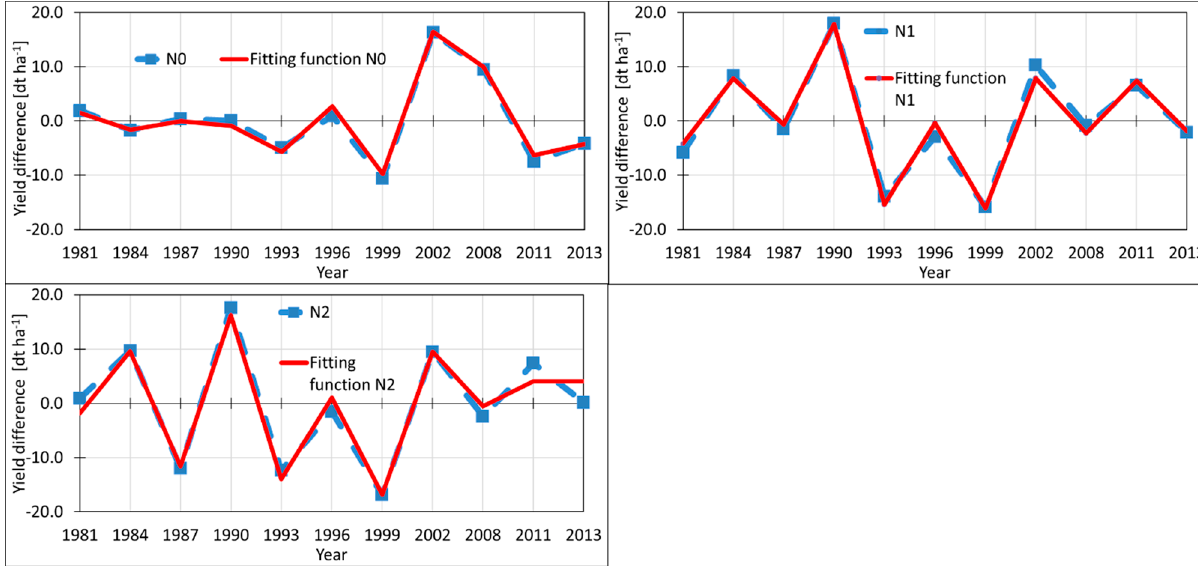
Figure 3. Measured and calculated residuals, with monthly independent variables for different fertilization levels (unfertilized plots (N0), moderately fertilized plots (N1), and highly fertilized plots (N2)).